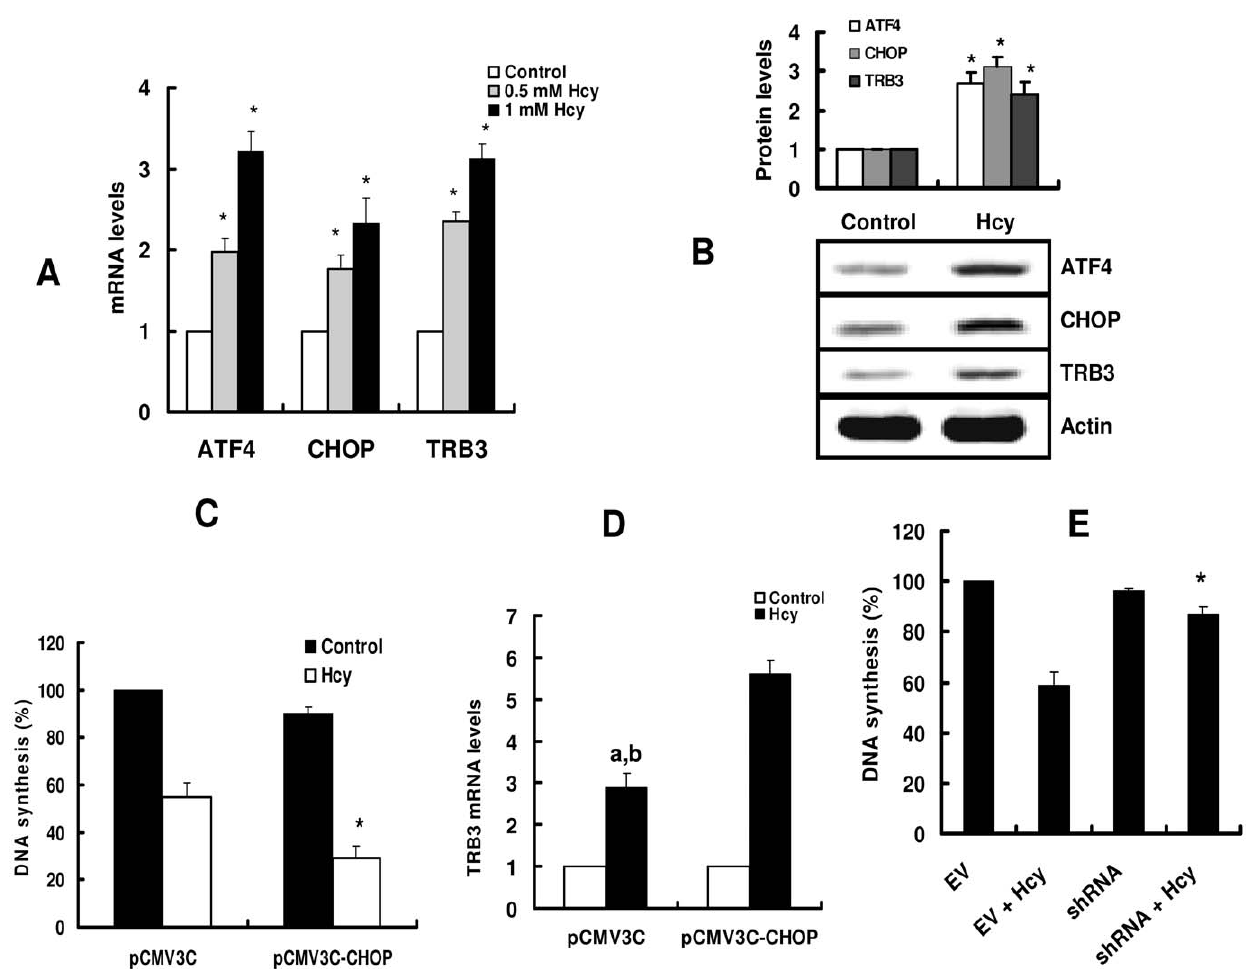
Figure 4. TRB3 is required for homocysteine-mediated cell growth arrest. (A) Primary cultured hepatocytes were incubated with 0.5 or 1 mM homocysteine (Hcy) for 8 h. Total RNA was extracted and subjected to real-time PCR. All results are standardized to the levels of actin and are the means 6 SD of five experiments. * P , 0.05 versus control (without Hcy). (B) Primary cultured hepatocytes were incubated with 1 mM Hcy for 8 h. The protein levels were detected by Western blotting. The blot is typical of three experiments. The upper part shows quantification of immunoreactivity levels. The data are expressed as percent change from control. * P , 0.05 versus control (without Hcy). (C-D) HepG2 cells were transfected with pCMV3C empty vector or pCMV3C-CHOP. The cell proliferation was assessed by [ 3 H]-thymidine incorporation into DNA after treatment with Hcy for 24 h (C). These results are means 6 SD of five experiments. * P , 0.05 versus pCMV3C (with Hcy). After incubated with 1 mM Hcy for 24 h, total RNA was extracted and subjected to real-time RT-PCR (D). a P , 0.05 versus control (without Hcy); b P , 0.05 versus Hcy + pCMV3C- CHOP. (E) Stable cell lines of HepG2 that express shRNA for TRB3 gene, were produced by transfection of pSilencer2.1-U6-shRNA. The cell proliferation was assessed by [ 3 H]-thymidine incorporation into DNA after treatment with Hcy for 24 h. EV, empty vector. * P , 0.05 versus EV +